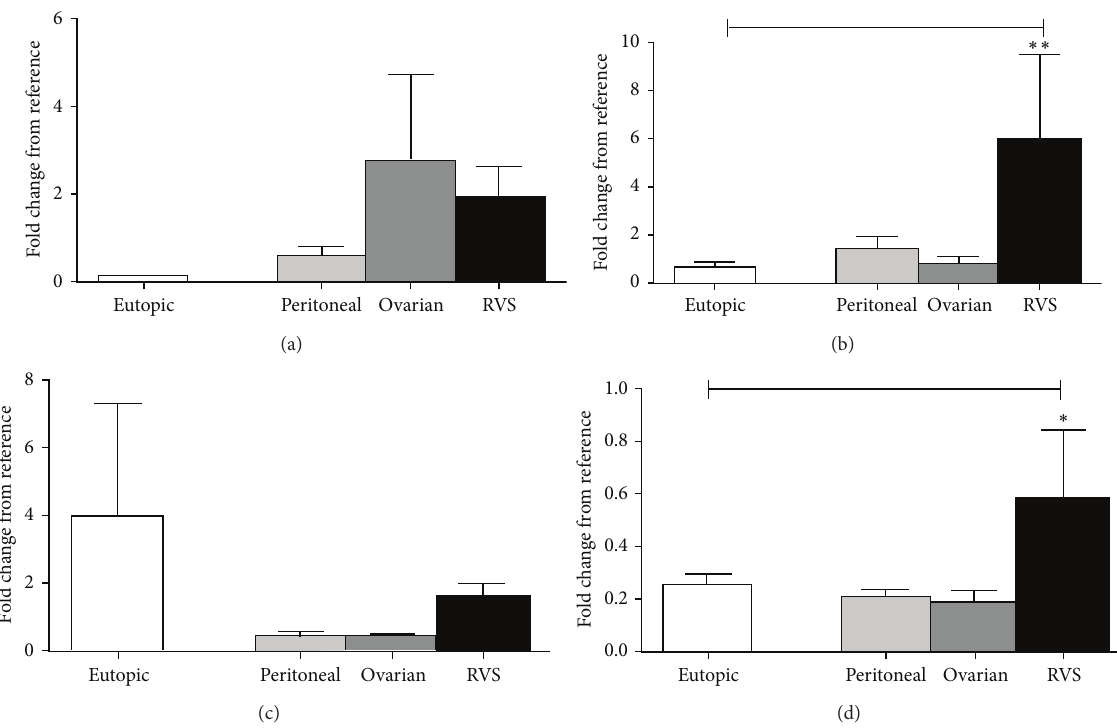
Figure 1: Chemokine production in eutopic endometrium and matching ectopic endometriotic lesions from different locations. (a) No significant difference was observed in the mRNA expression of MCP-1. (b) ENA-78 mRNA expression was significantly stronger in the RVS lesions compared to its matching eutopic tissue. (c) No significant difference in IL-8 mRNA expression was observed between the eutopic endometrium and the ectopic lesions from different locations. (d) RANTES expression was significantly higher in the RVS lesions compared to the eutopic endometrium. All values are represented by mean ± SEM. ∗ < .05 , ∗∗ < .01 .